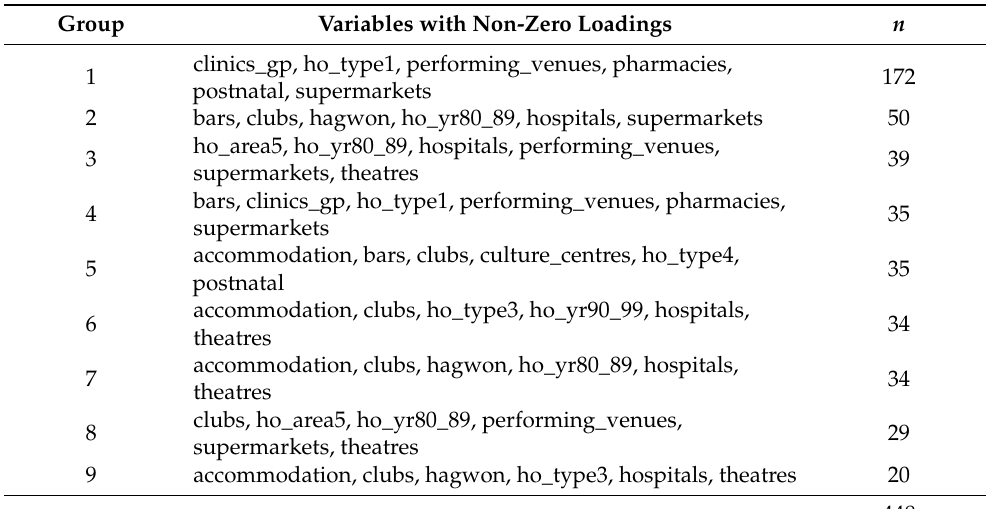
Table 4. Groups based on the variables with non-zero loadings in the first sparse component and the number of grids in each group, n